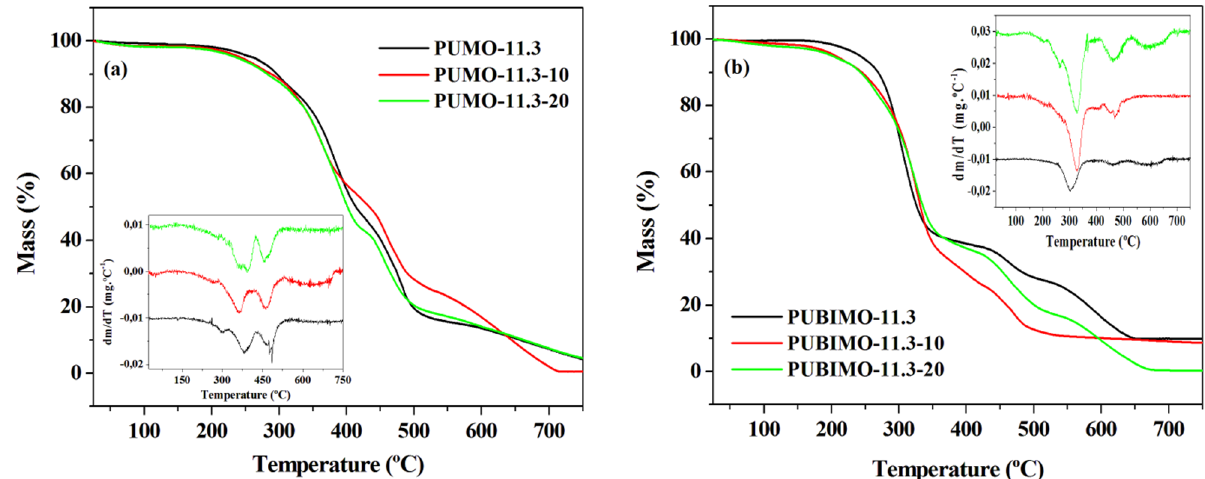
Figure 6. TG and DTG curves of: ( a ) PUMO-11.3, PUMO-11.3-10, and PUMO-11.3-20; ( b ) PUBIMO-11.3, PUBIMO-11.3-10, and PUBIMO-11.3-20, acquired at a heating rate of 10 °C·min − 1 .